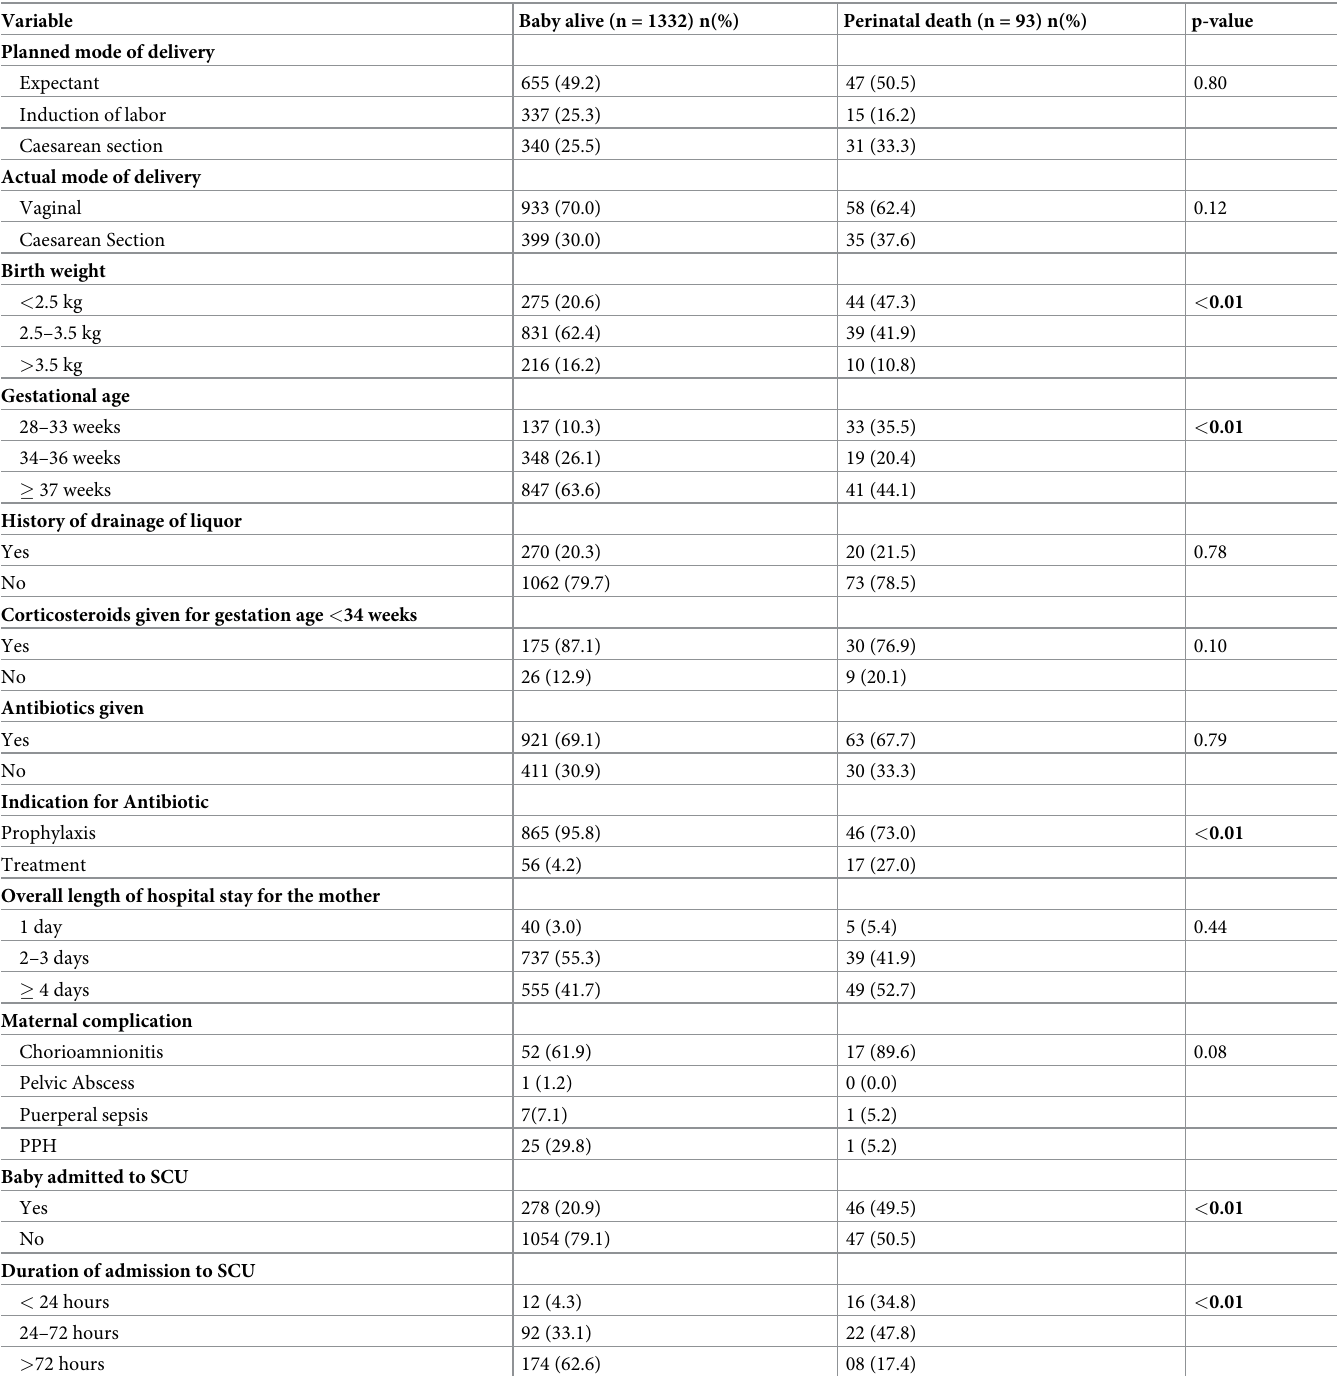
Table 3. Maternal and neonatal characteristics associated with perinatal